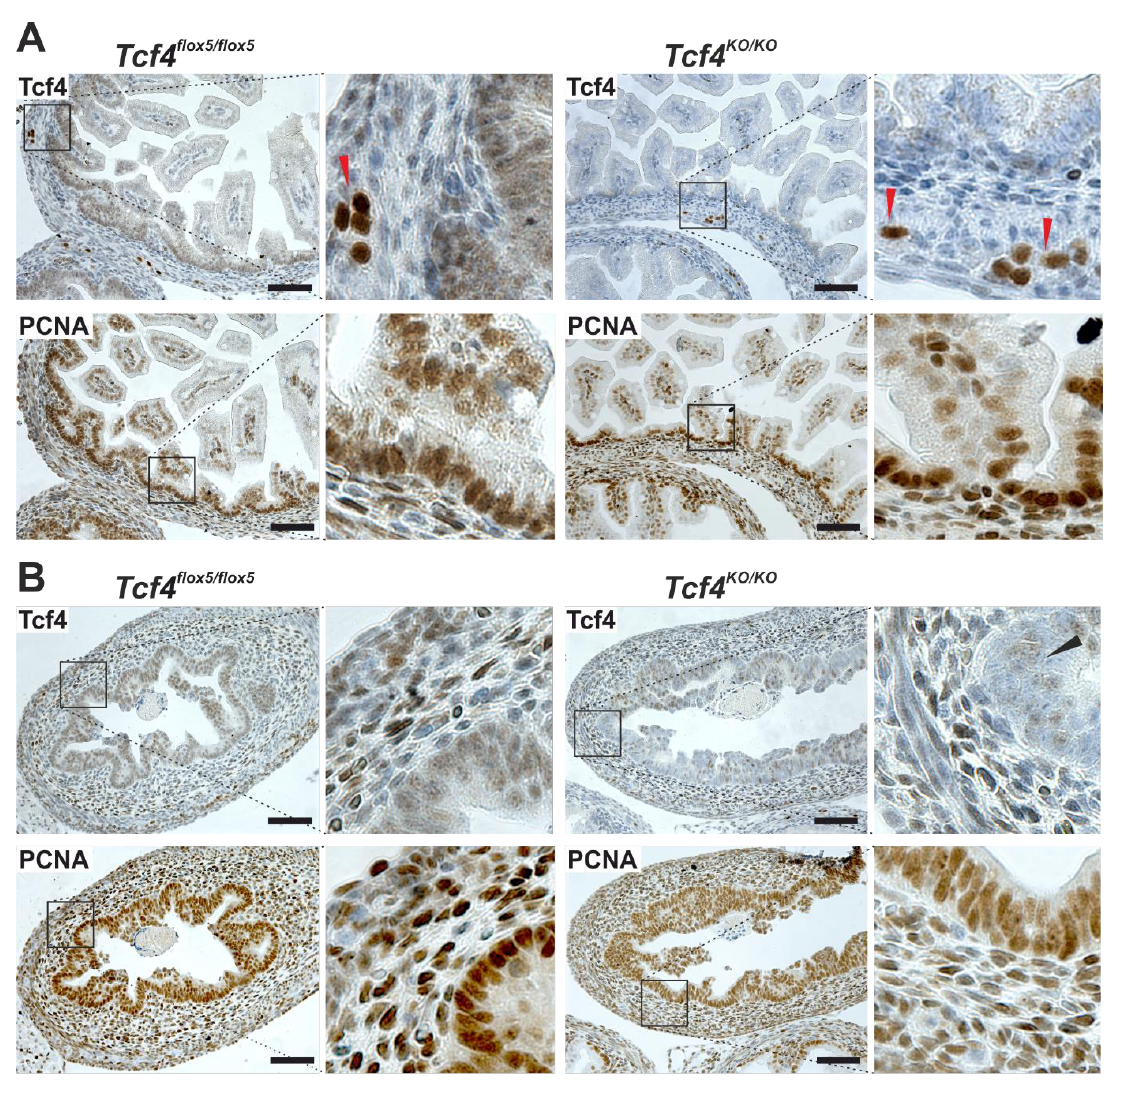
Figure 2. Normal development of the embryonic gut upon Tcf4 inactivation. Immunohistochemical analysis of the small intestine ( A ) and colon ( B ) of Tcf4 flox5/flox5 and Tcf4 flox5/flox5 Villin-Cre ( Tcf4 KO/KO ) mice at embryonic day (E) 17.5. Notice the Tcf4 nuclear positivity in the intervillus regions of Tcf4 flox5/flox5 mice that is missing in Tcf4 KO/KO animals. The regions retain their proliferation, as evidenced by proliferating cell nuclear antigen (PCNA) staining. The colon is less developed; however, no obvious phenotype related to the Tcf4 loss is visible. Inactivation of the floxed Tcf4 alleles in the colon is incomplete, since groups of Tcf4-positive cells are present in the tissue (black arrowhead). In mice of both genotypes, Tcf4-positive cell nuclei are also detected in the small intestinal enteric plexus (red arrow heads) and in the subepithelial layers of the colon. Specimens were counterstained with hematoxylin. Magnified images are shown at the right. Scale bar: 0.3 mm.